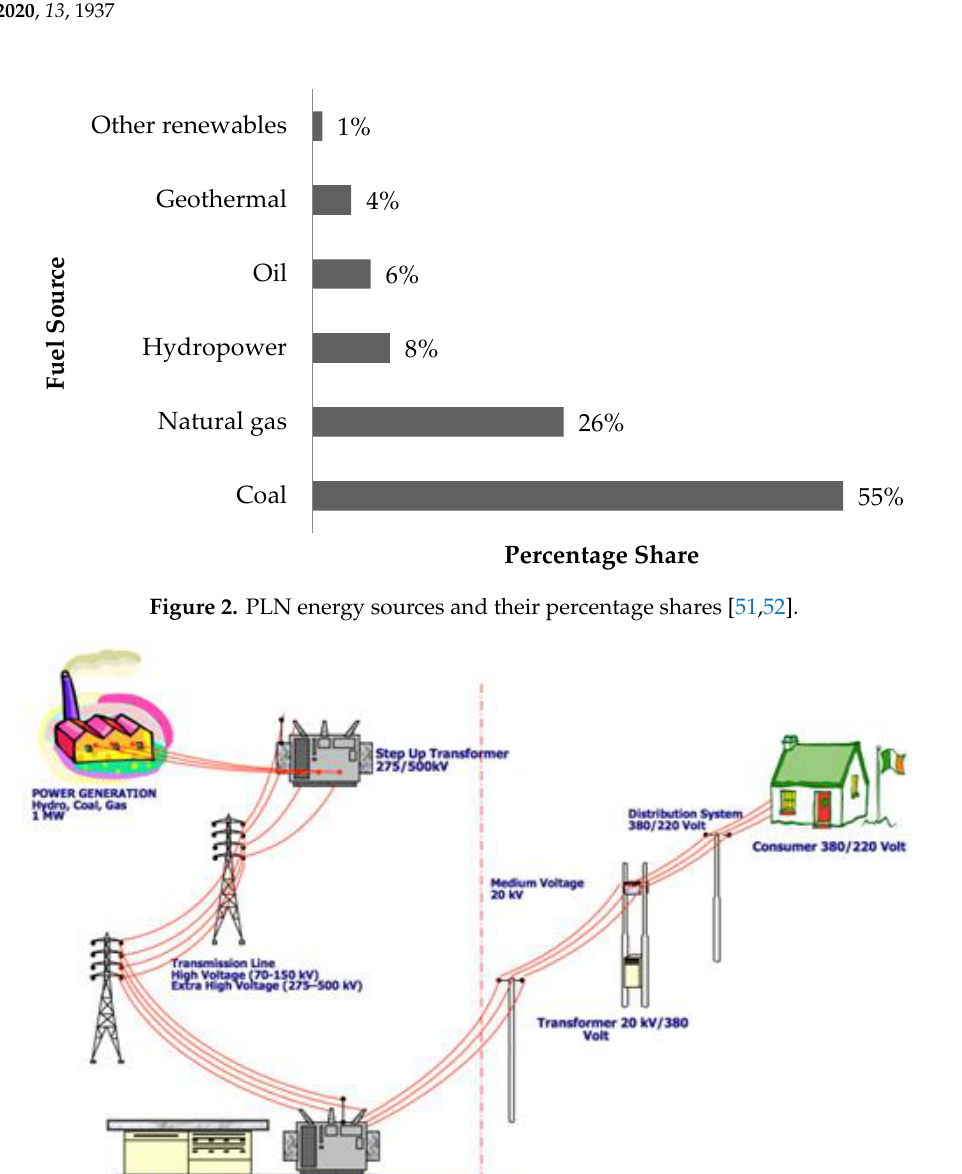
Table 2. Transformer population and capacities from 2011 and 2016 [51,52].